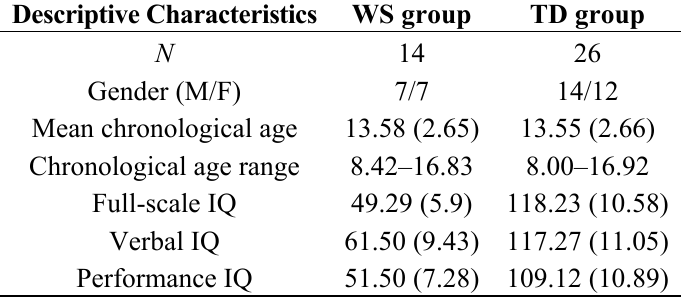
Table 1. Descriptive characteristics of the Williams syndrome (WS) and typically developing (TD) groups. Values presented in parentheses represent standard